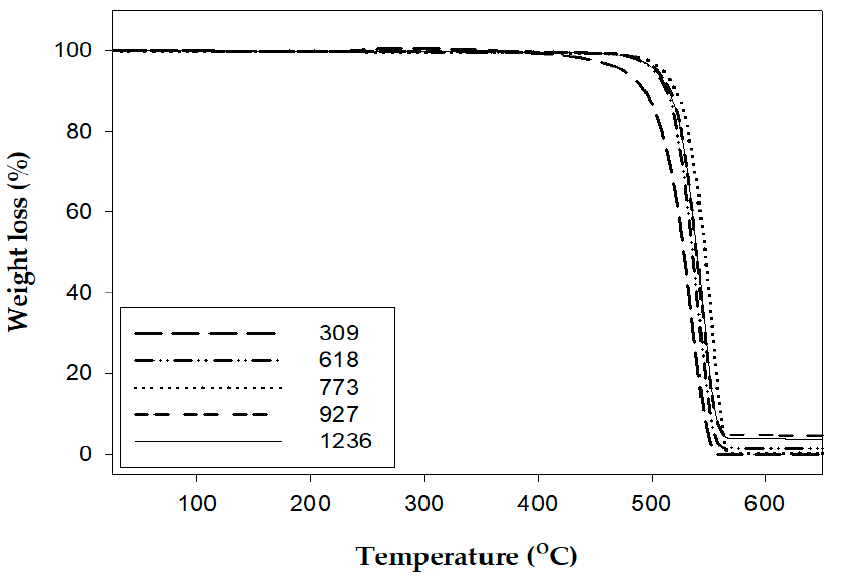
Figure 5. TGA thermograms of the ethylene homopolymerization carried out using various [Al]/[Ti] molar ratios.